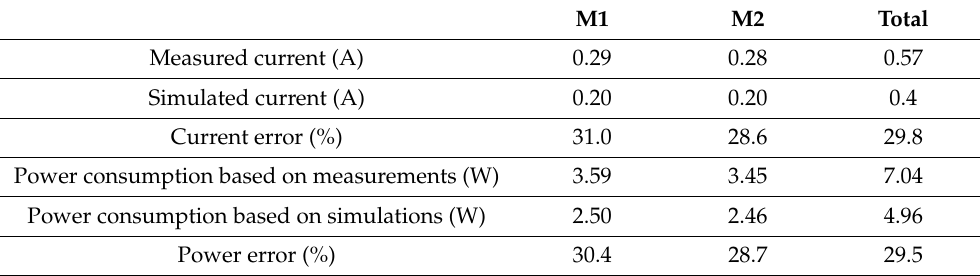
Table 13. Current and power consumption values of the motors and the entire mobile robot with two drive